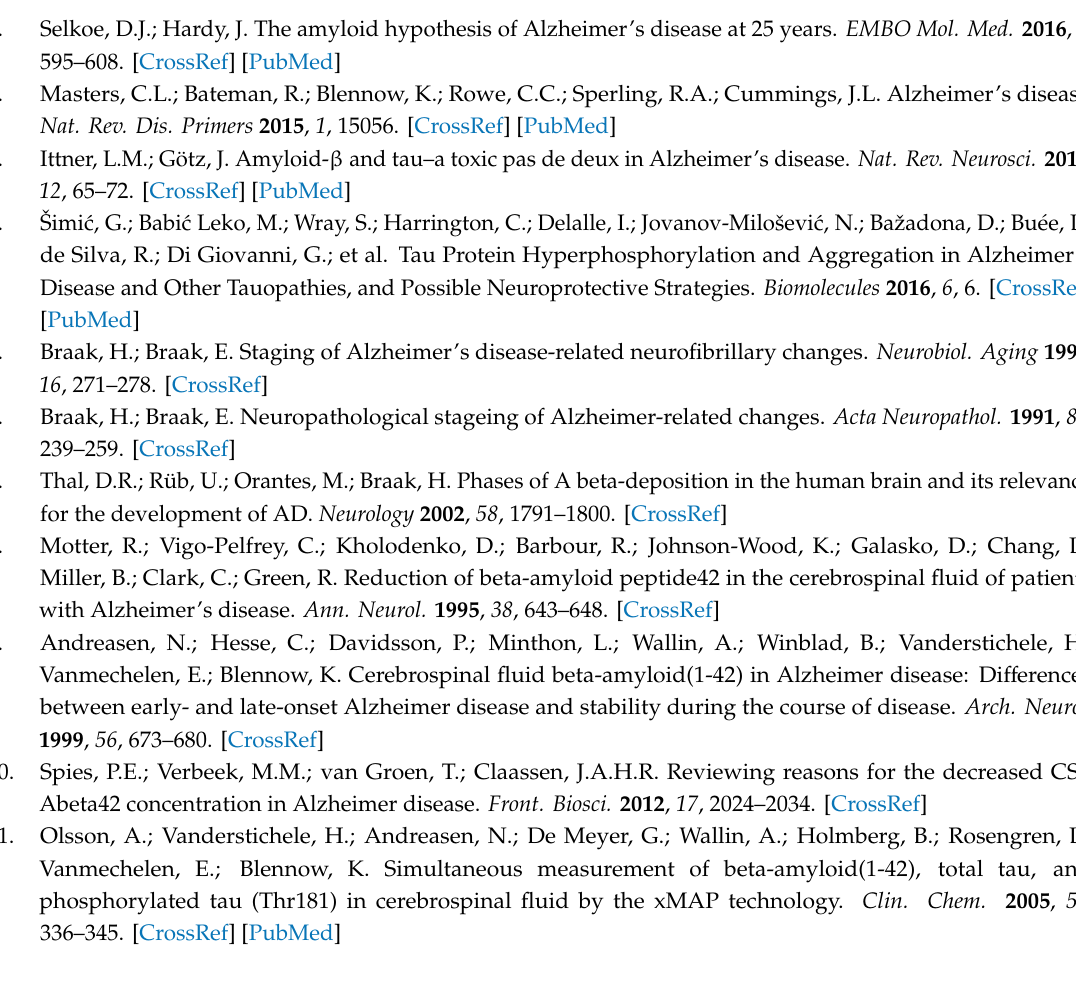
Figure S1: The canonical pathway of identified proteins by TMT-labeling quantitative proteomics in IPA. Figure S2: Quantitative analysis of HBB and PRDX2. Figure S3: Comparison of total tau and tau phosphorylated at threonine 231 in EVs among AD, MCI and CTRL. Table S1: Patient Demographic Information. Table S2: Identification of EV proteins isolated from AD CSF by label-free proteomics analysis. Table S3: Identification of the EV and non-EV marker proteins. Table S4: Cell type specific list for label-free proteomics dataset. Table S5: Identification and quantification of EV proteins separated from AD, MCI, and CSF by TMT-labeled proteomics analysis. Table S6: Sample used for t-tau and p-tau ELISA